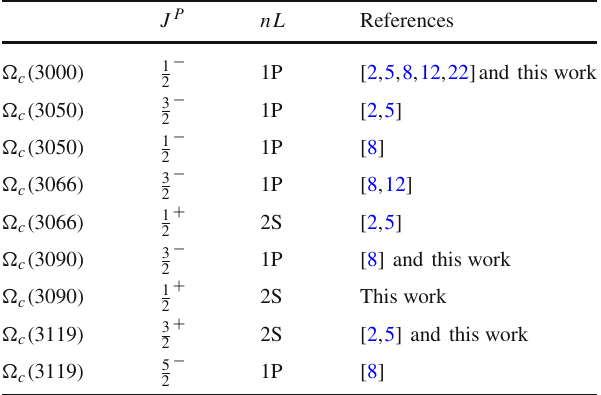
Table 3 The possible assignments of the new (cid:2) c states based on the QCD sum rules J P